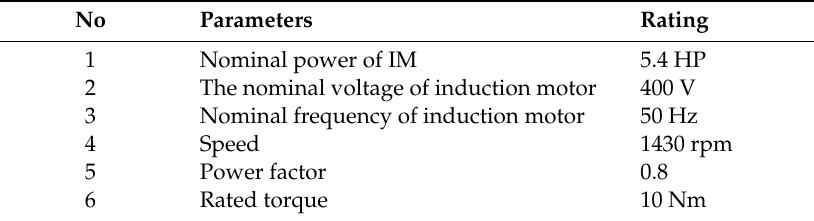
Table 3. Characteristics of induction motor (industrial